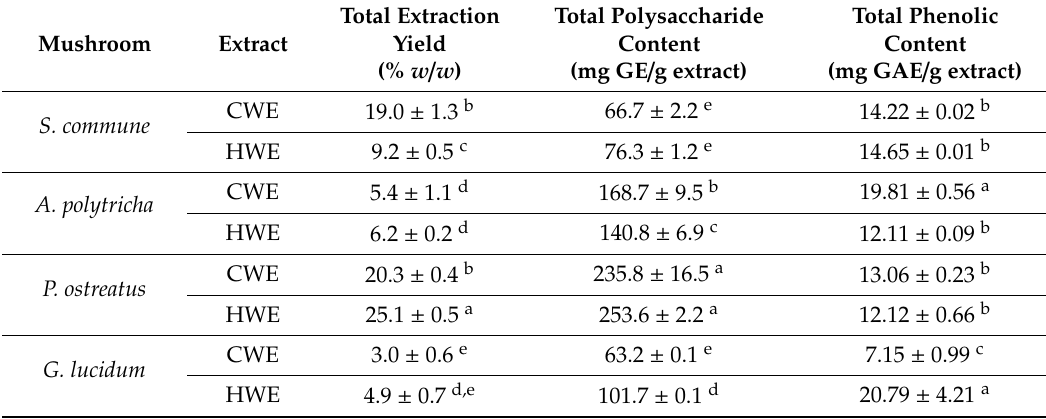
Table 1. Extraction yield, total polysaccharide content and total phenolic content of extracts from multiple types of